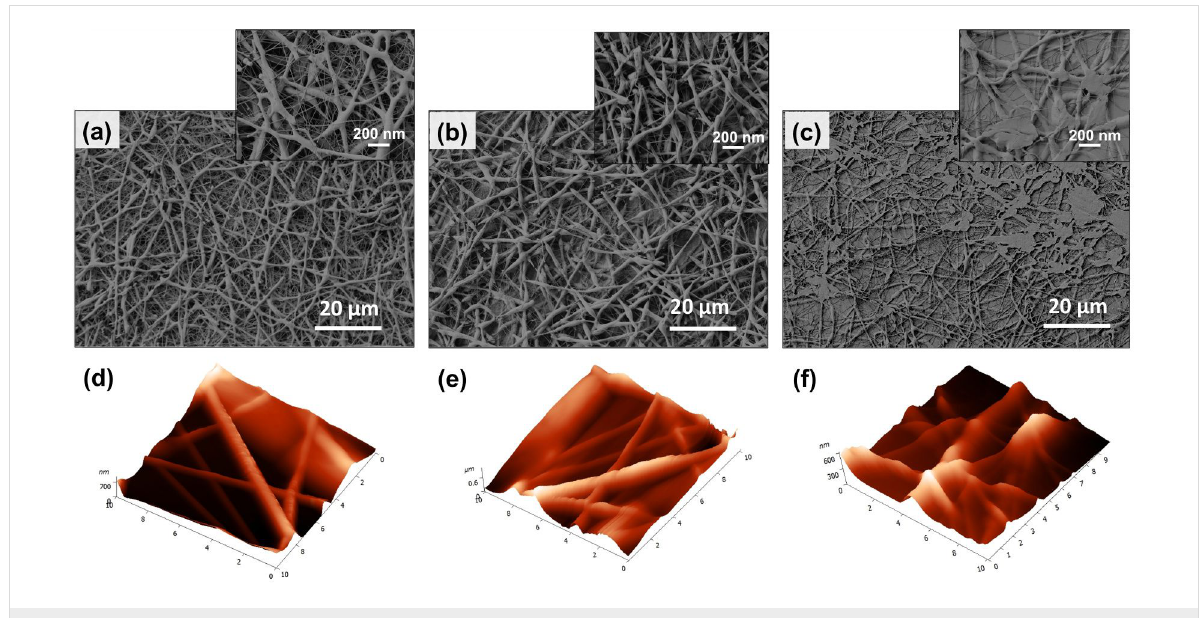
Figure 1: SEM and AFM images of the (a,d) untreated PCL electrospun scaffolds and of the O 2 -plasma modified ones, with (b,e) P = 20 W and (c,f) P = 40 W (the axis in AFM images is in μ m).